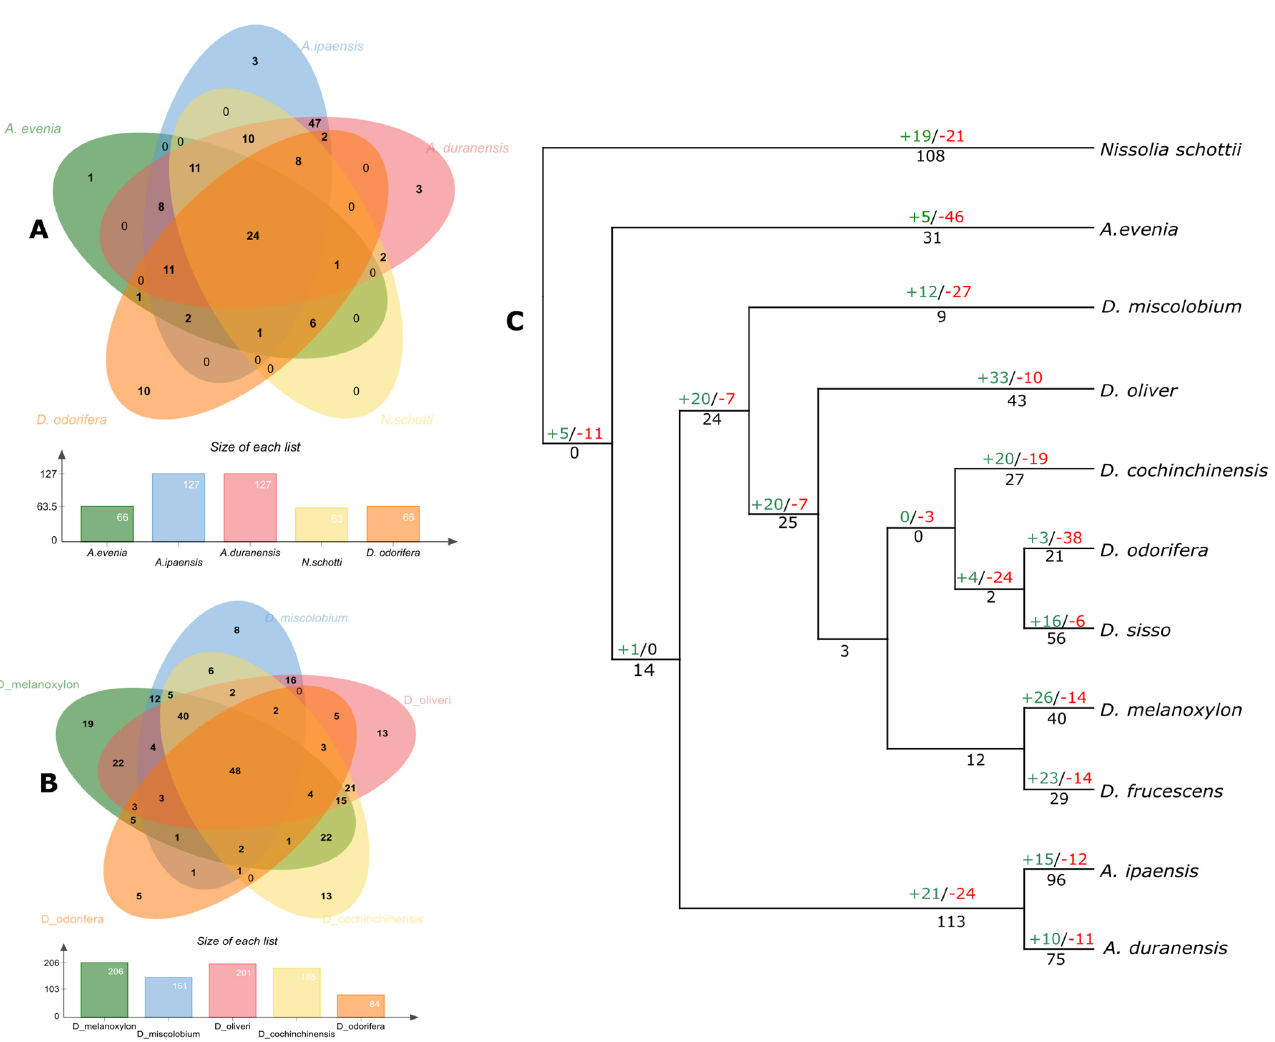
Figure 4. Gene orthologs and number of gene gains and loss analysis: ( A , B ) Venn diagrams illustrate the distribution of a number of shared and common genes regarding A- and B-related genome species. ( C ) Each node represents the number of genes, for instance, gene duplication is indicated in black font, and gene gain and loss are shown in green and red color, respectively.